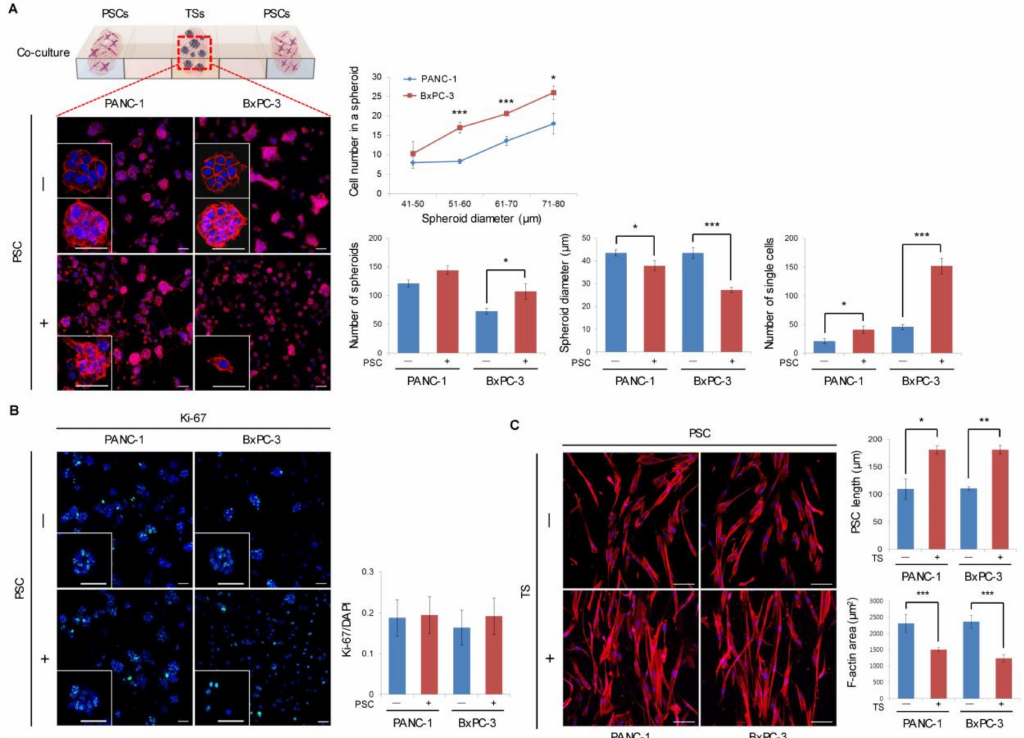
Figure 1. Formation and growth of pancreatic tumor spheroids (TSs) in a collagen matrix with or without pancreatic stellate cells (PSCs). ( A ) Compactness, number, and size of TSs and single-cell dissemination for PANC-1 and BxPC-3 cells in the presence or absence of PSCs. Scale bar: 50 µ m. ( B ) Level of the Ki-67 proliferation marker under PSC co-culture conditions. Scale bar: 50 µ m. ( C ) Changes in morphology of PSCs when co-cultured with PANC-1 or BxPC-3 TSs. Scale bar: 100 µ m. Cells were grown for 5 days in collagen-supported microchannel chips and stained with F-actin, Ki-67, and DAPI. Cells up to 20 µ m in diameter were counted as single cells. Three fields covering 80% of the e ff ective area in each channel were imaged per experiment and subjected to analysis. Data were obtained from three separate independent experiments. * p < 0.05, ** p < 0.01, *** p <